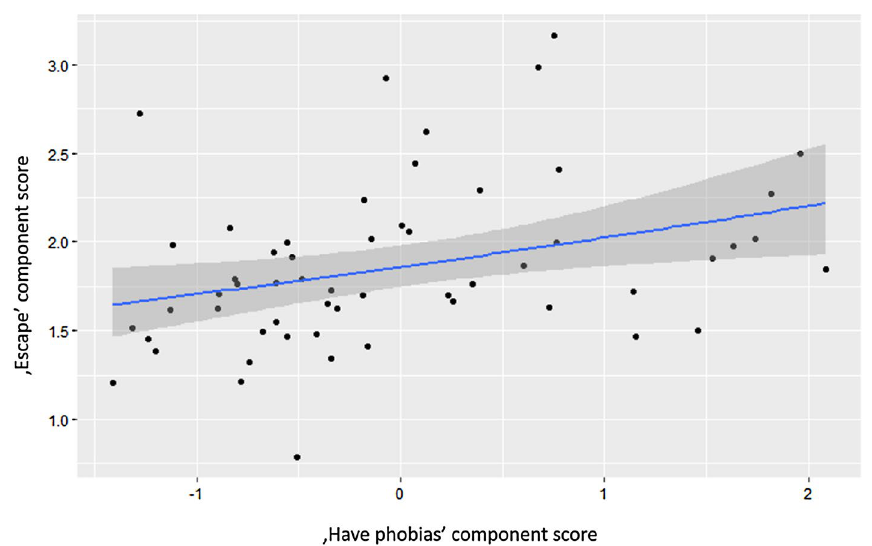
Figure 1. The relationship between ’Have phobias’ and ’Escape’ component